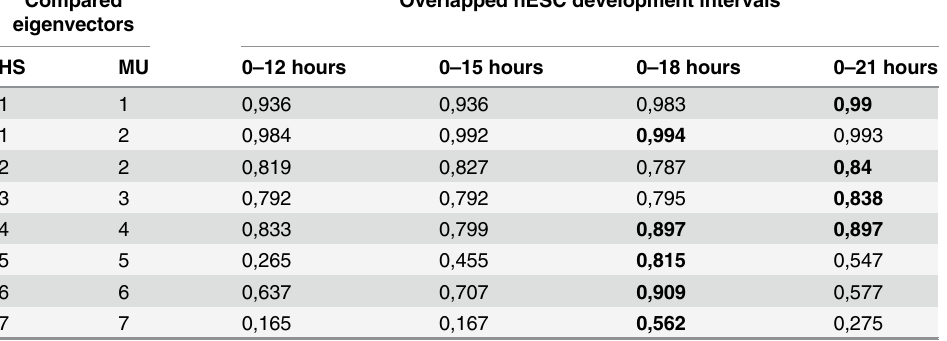
Table 3. Correlation (quantified by Pearson correlation coefficient) of eigenvectors from Principal Component Analysis (PCA) at different time intervals of hESC development with eigenvectors of 0 – 10 hour mESC